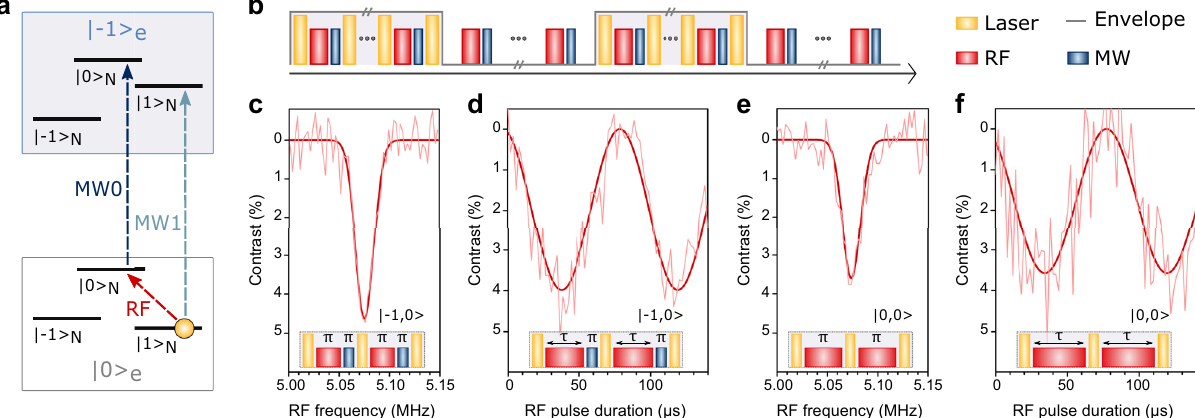
Fig. 4 Electrical readout of individual nuclear spin. a Schematic of the NV ground state hyper fi ne energy-level structure of the |m s 〉 = |0 〉 and |m s 〉 = | − 1 〉 states depicting the resonant frequencies of the probed transitions (RF: radiofrequency, MW0: resonant microwave frequency to selectively excite the electron spin in |m I 〉 = |0 〉 , MW1: resonant microwave frequency to selectively excite the electron spin in |m I 〉 = | + 1 〉 ). b Scheme of the envelope pulse train designed for electrical readout of a single nuclear spin using the lock-in detection technique. Here, the lock-in ampli fi er is triggered by the on/off envelope modulation of the laser pulses. c Electrically-detected RF resonant frequency of the |0, + 1 〉 and |0,0 〉 transitions of the single 14 N nuclear spin measured at 439 G. Inset shows the pulse sequence used, consisting of RF and MW0 π -pulses. d Corresponding electrically-detected Rabi oscillations of the single nuclear spin with the pulse sequence shown in the inset. e Electrically-detected RF resonant frequency of the |0, + 1 〉 and |0,0 〉 transitions of the single 14 N nuclear spin without electron spin manipulation measured at 439 G. Inset shows the pulse sequence used consisting of RF π -pulses. f Corresponding electrically-detected Rabi oscillations of the single nuclear spin with the pulse sequence shown in the inset (experimental conditions: 4000 ns laser pulse of 6 mW power, 400 ns long MW π -pulse, 1 W RF